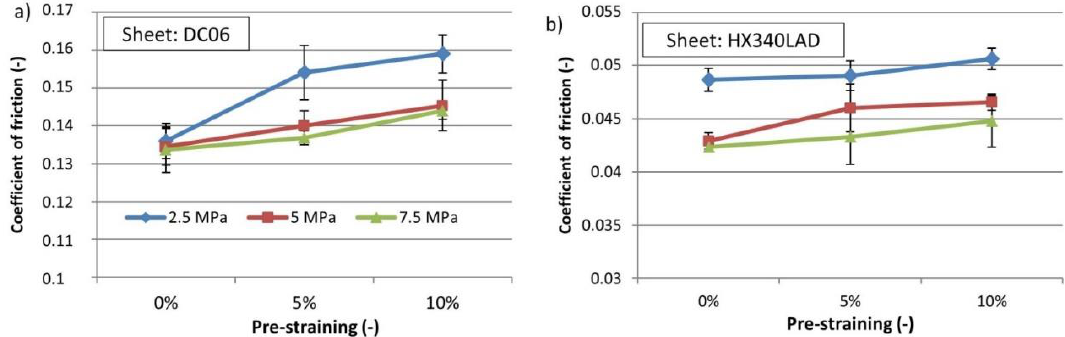
Figure 12. Coefficient of friction for different contact pressures and pre-straining considering a constant sliding velocity of 50 mm/s ( a ) Material DC06 with electrolyte galvanized coating ( b ) Material HX340LAD with galvanized coating.